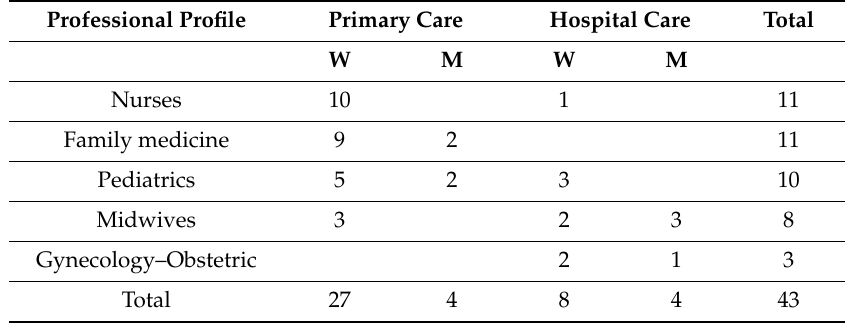
Table 2. Health professionals who participated in the study. Professional Profile Primary Care Hospital Care Total W M W M Nurses 10 1 11 Family medicine 9 11 Pediatrics Midwives